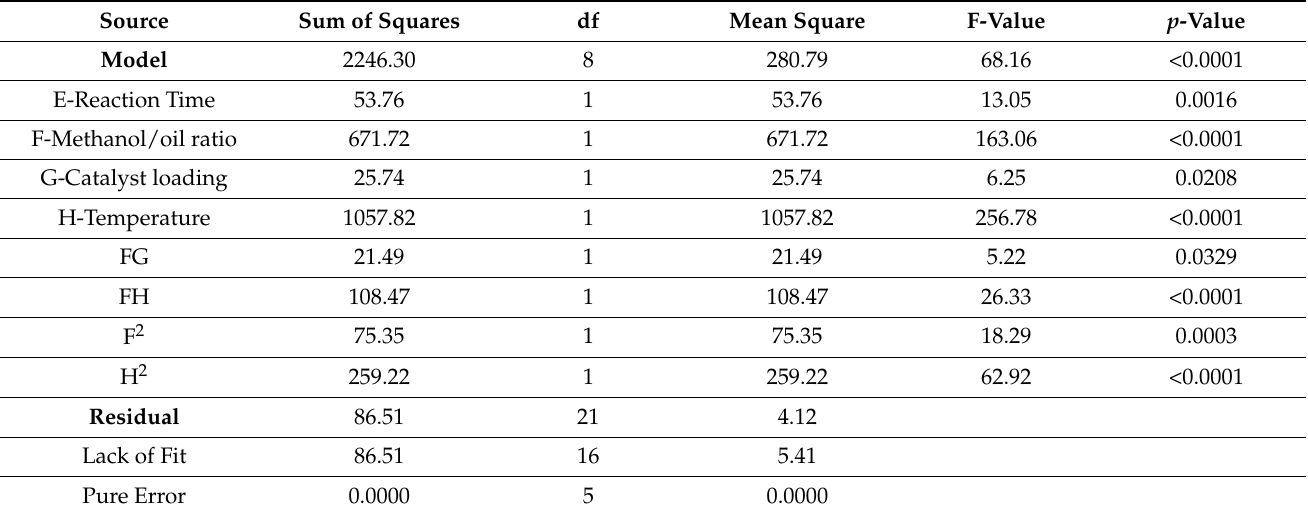
Table 10. Biodiesel conversion ANOVA analysis.